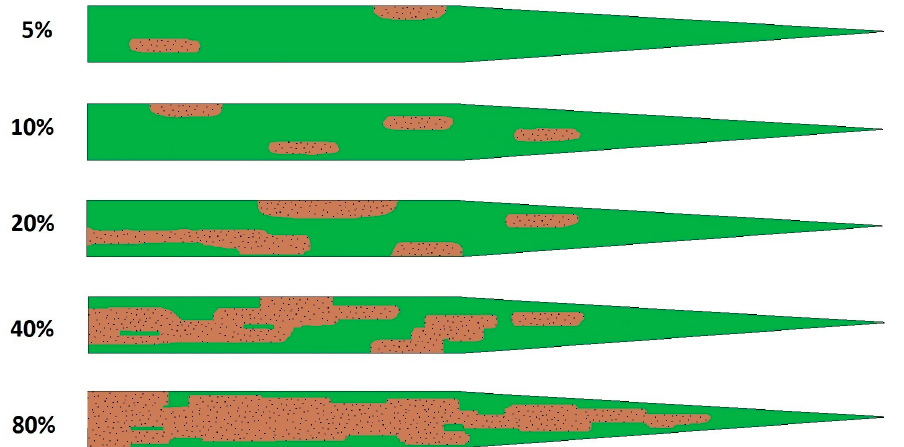
Figure 2. Simplified scale of Septoria infestation wheat flag leaf, based on the percentage coverage of the leaf by spots.